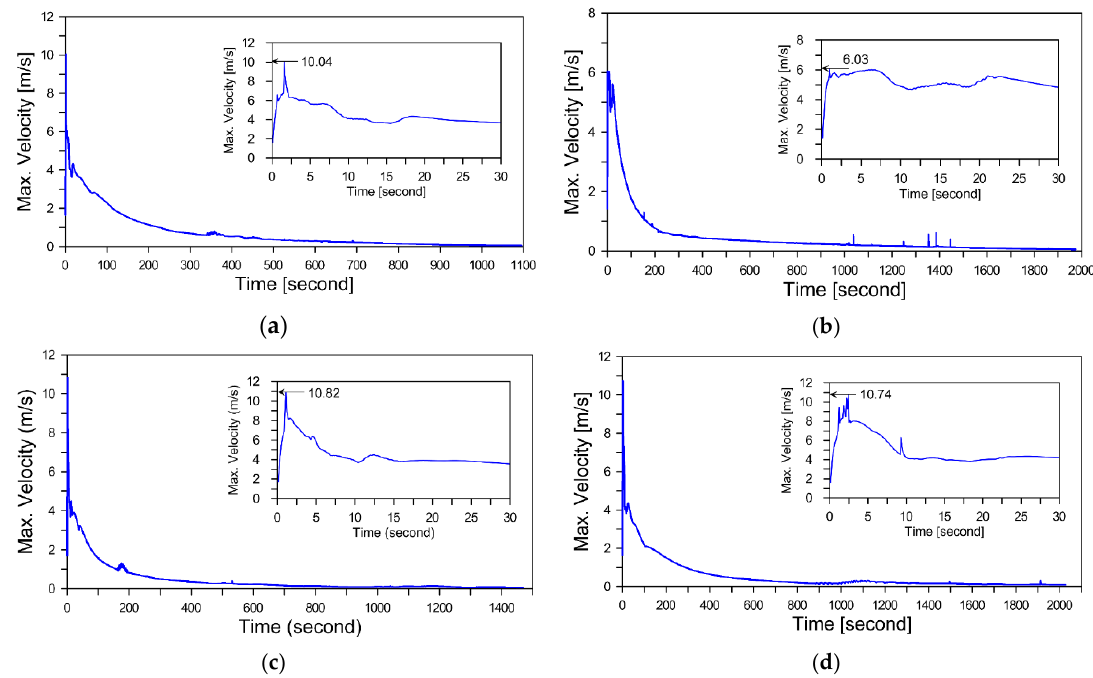
Figure 16. Simulation of maximum flow speeds over the flow period in each watershed. ( a ) Watershed A, ( b ) Watershed B, ( c ) Watershed C, ( d ) Watershed D.